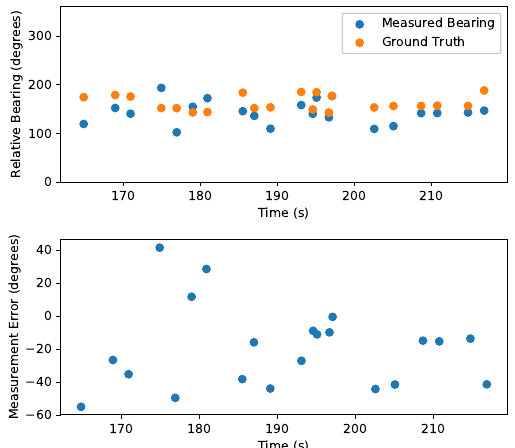
Figure 15. Measurement error during quadrotor lighthouse experiment. Top: bearing measurements compared to actual relative bearings determined by ground truth data. Bottom: measurement error. The error bias (mean error) was − 19.5 degrees, and the standard deviation was 24.7 degrees. This